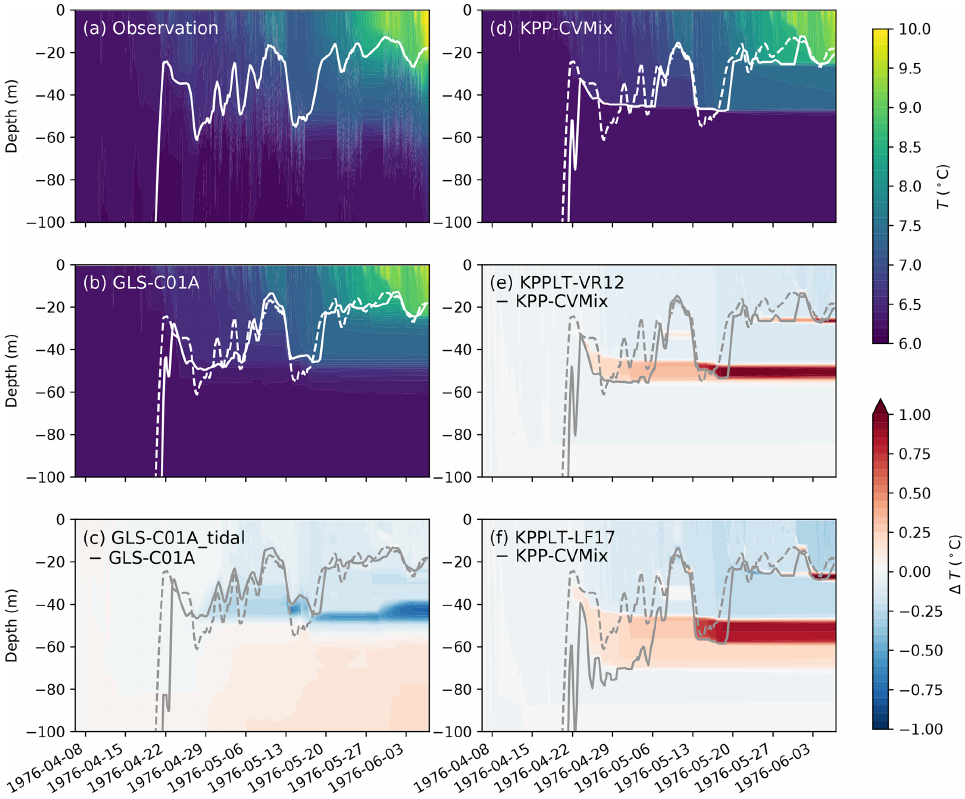
Figure 10. Hovmöller diagrams comparing the observed and simulated temperature between the four vertical mixing schemes in the FLEX case. Panel (a) shows the observed temperature. Panel (b) shows the simulated temperature in GLS-C01A. Panel (c) illustrates the effect of tidal forcing by showing the difference between GLS-C01A with and without tides. Panel (d) shows the simulated temperature in KPP- CVMix. Panels (e) and (f) show the differences from KPP-CVMix in KPPLT-VR12 and KPPLT-LF17. Solid lines show the MLD (m) in each case defined by a 0.2 ◦ C temperature threshold referenced to the surface. For reference, the observed MLD is also shown in panels (b) – (f) in dashed